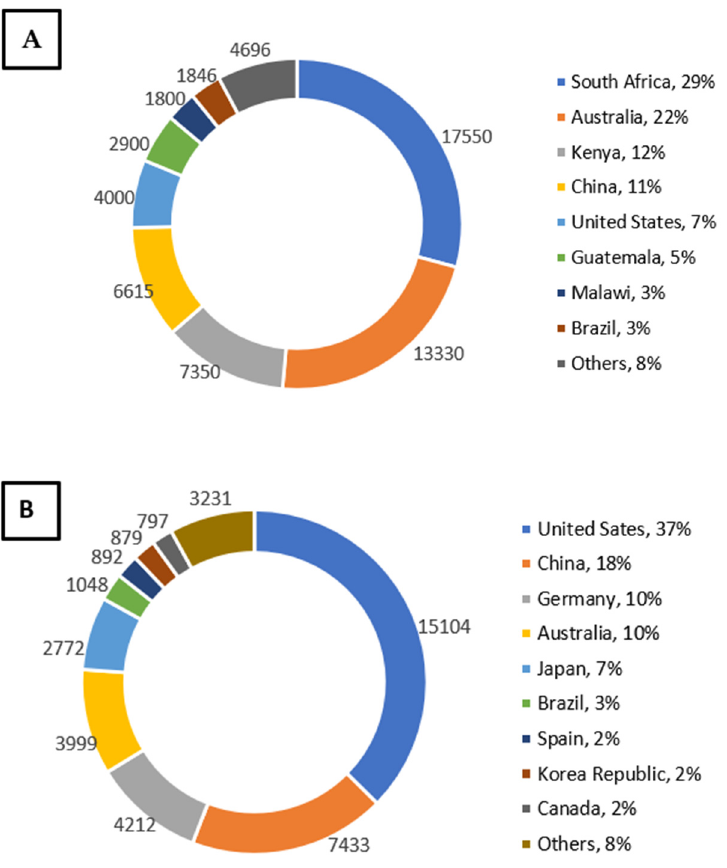
Figure 2. ( A ) World estimated macadamia nut production (metric ton) and ( B ) consumption (metric ton) in 2018. Adapted from: International Nut and Dried Fruit Council [7].